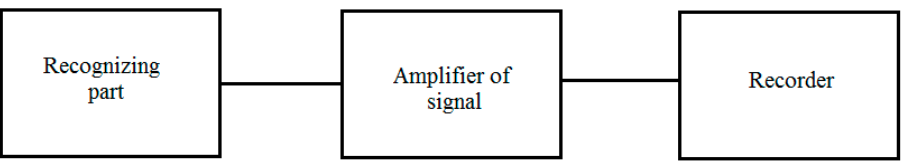
Figure 2. The construction of laboratory models of biosensors.